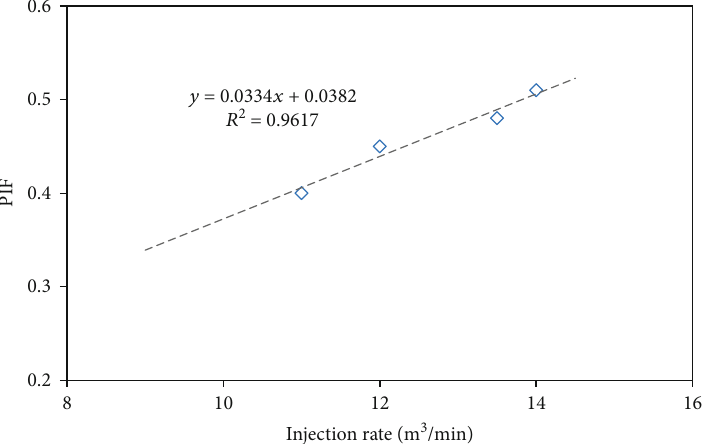
Figure 10: Preferable injection rate based on PIF.